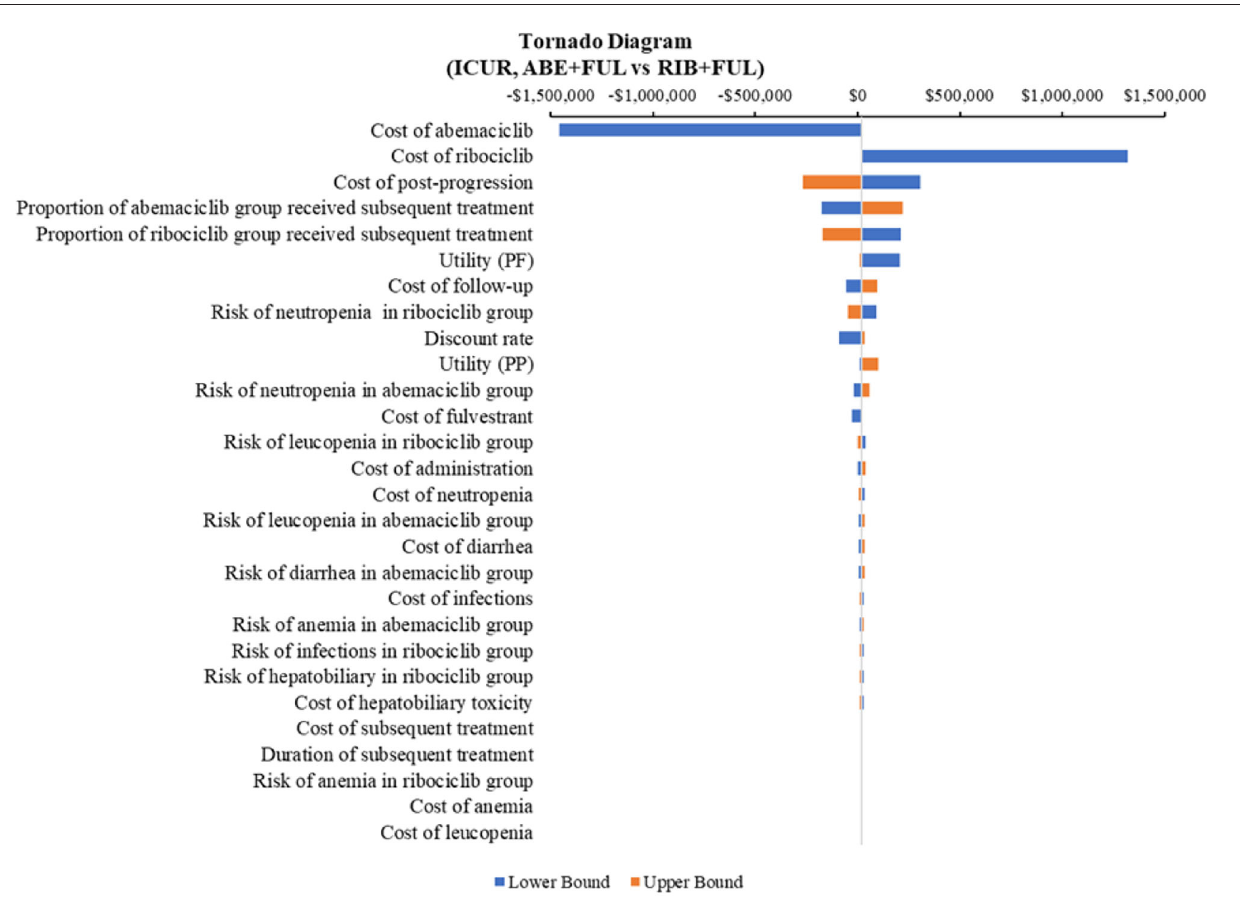
FIGURE 6 | Tornado diagram of the abemaciclib plus fulvestrant vs. ribociclib plus fulvestrant. ICUR, incremental cost-utility ratio; ABE, abemaciclib; RIB, ribociclib; FUL,